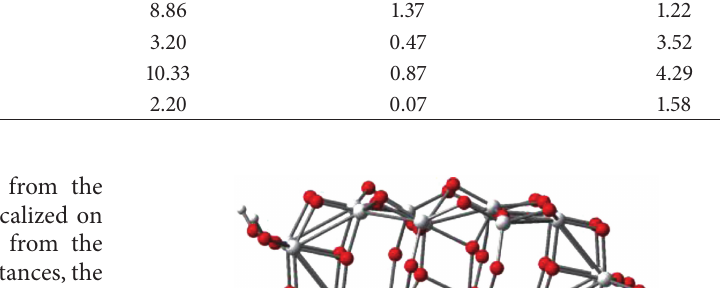
Table 3: Contributions of the oxygen atoms (O from the − OH group, O 󸀠 from the − COOH group, and all from the − SO together), in %, to the electron density of the HOMO and LUMO, calculated at DFT/B3LYP/6-31+G(d) level. Dye MO O ( − OH) O 󸀠 ( − COOH) 3 × O ( − SO H2-ACY 2 − (missing H1 and H3) H1H2-ACY − (missing H3) H3-ACY 2 − (missing H1 and H2) H1H3-ACY − (missing H2)